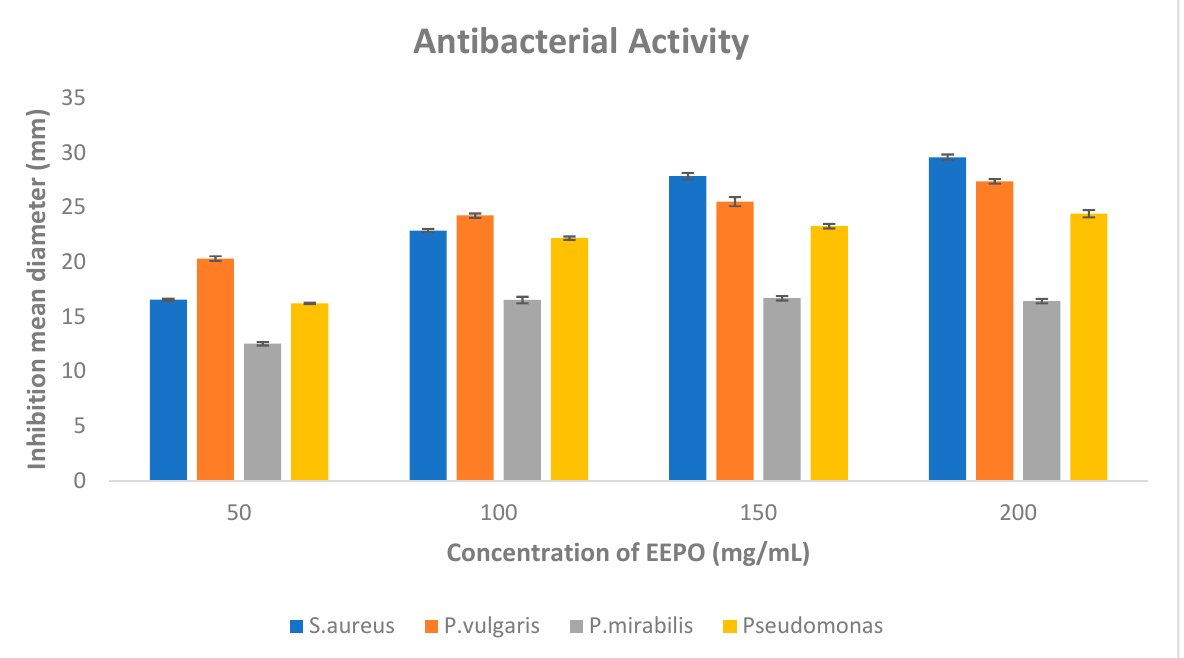
Table 3. Antibacterial activity of EEPO. Results are recorded as mean ± standard deviation.